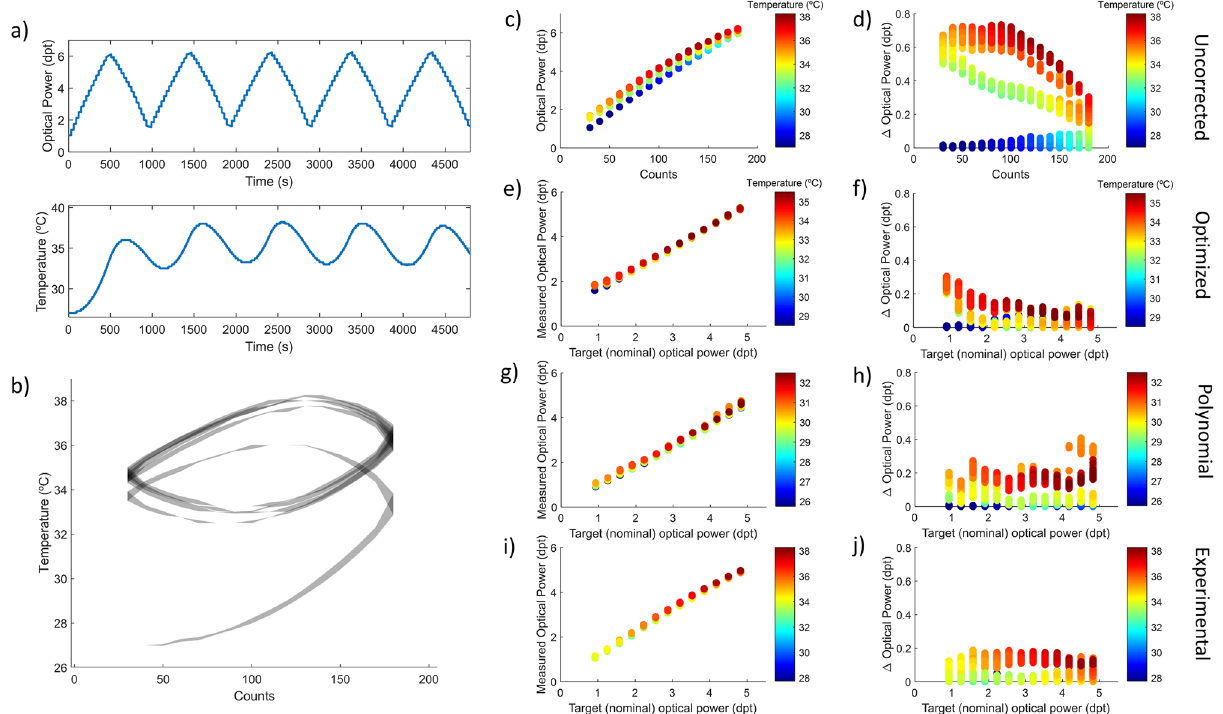
Figure 5. Hysteresis experiment description and performance of the three compensation methods used to correct temperature effect. ( a ) Optical power and temperature profile of the lens during a hysteresis experiment. ( b ) Internal temperature variation and stability region. ( c,d ) Optical power measured values and deviations with respect to nominal value when no temperature correction is applied. ( e,f ) with optimized model for temperature compensation. ( g,h ) with polynomial model compensation and ( i,j ) with experimental model